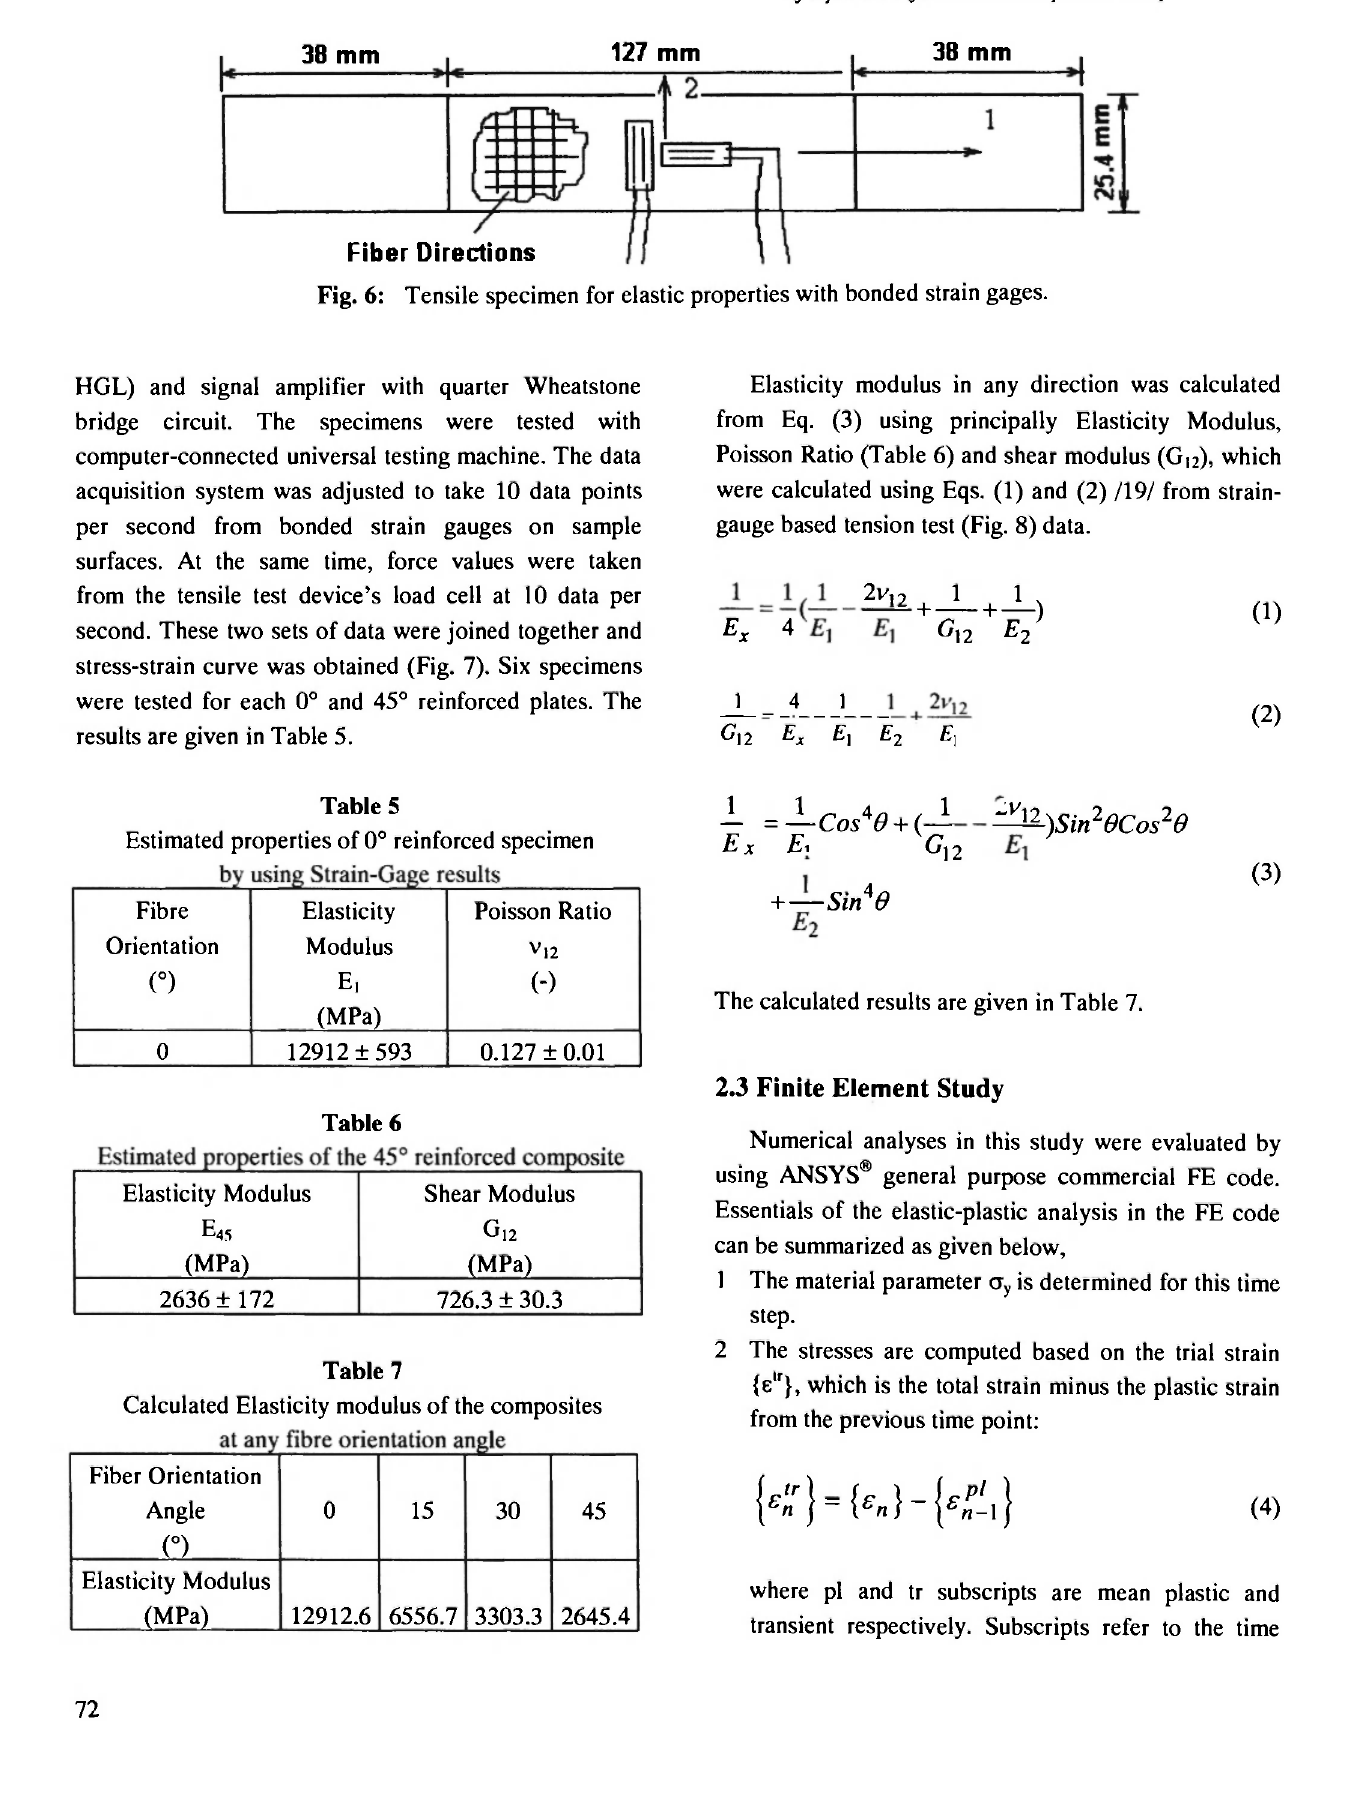
Fig. 6: Tensile specimen for elastic properties with bonded strain